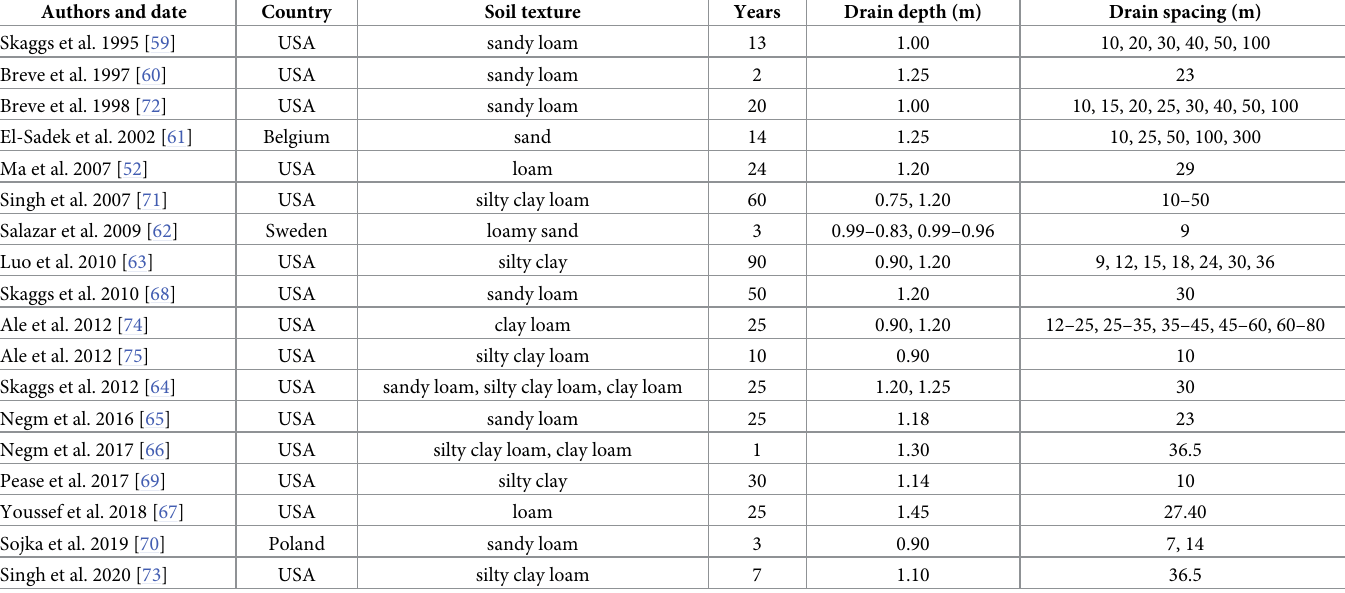
Table 1. Characteristics and information of studies evaluated in the